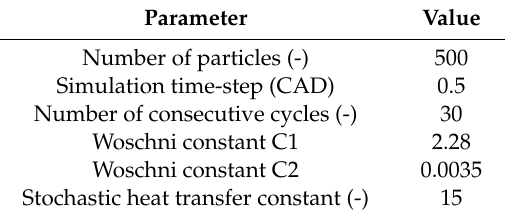
Table 8. SRM main model settings for the spark-ignition engine simulation campaign.